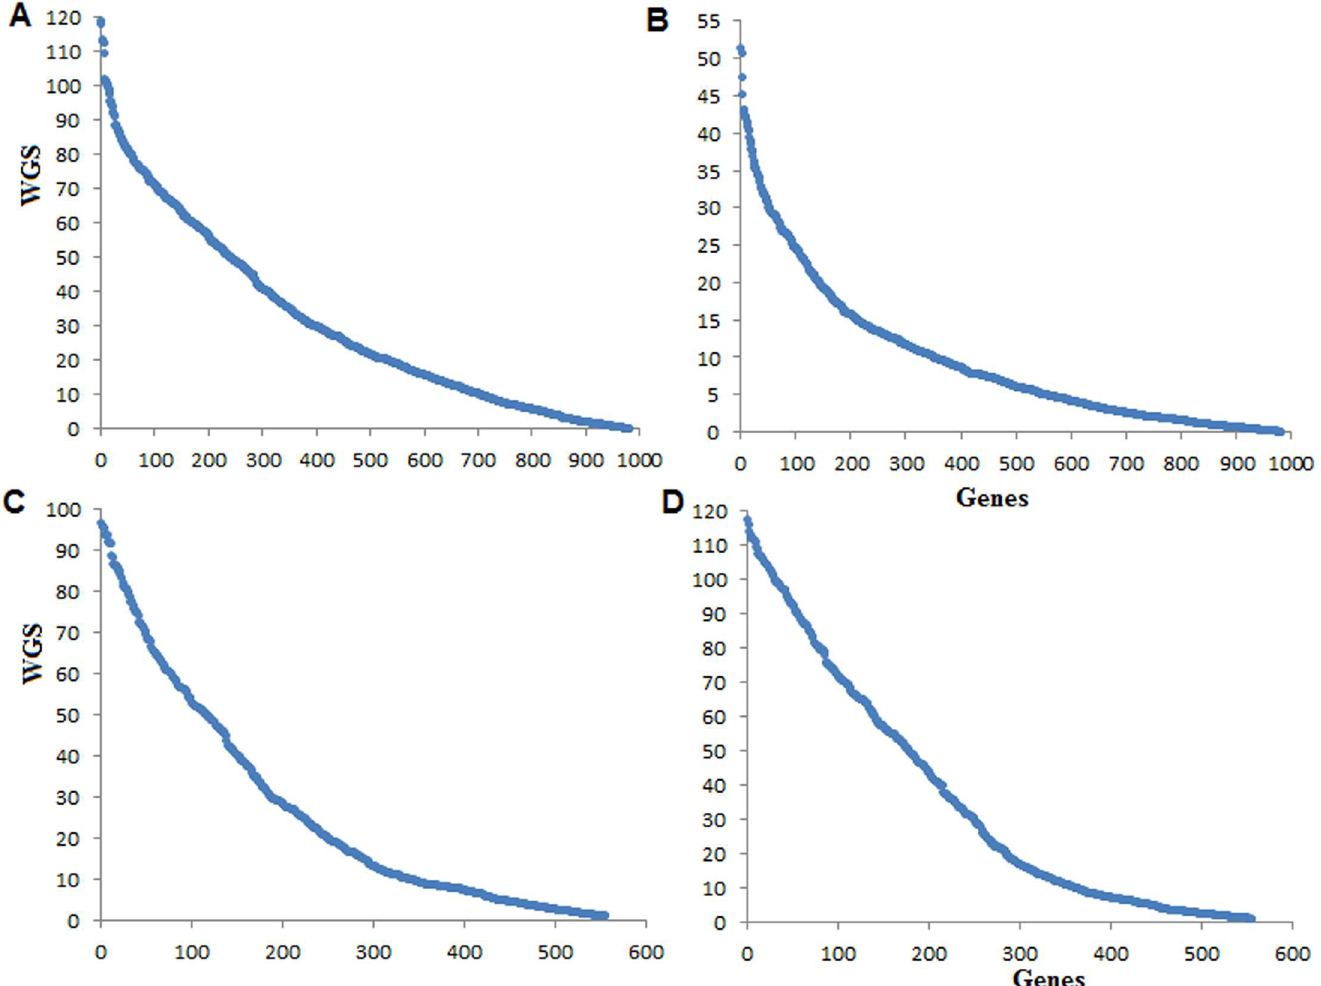
Fig 5. Distribution of WGS in complete networks under stress and control conditions. The distributionsof WGS of genes in GCNs for Al stress (A) and control (B) conditions in soybeanare shown. The distributions of WGS of genes in GCNs for salinity stress (C) and control (D) conditions in rice are shown. For all these cases, the distributionsare heavy